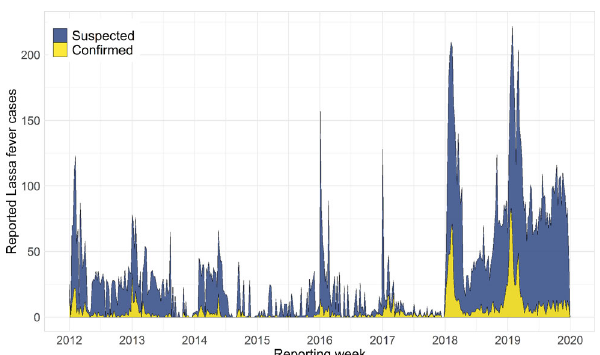
Fig. 1 Temporal trends in country-wide Lassa fever case reporting from 2012 to 2019. Polygon height shows the weekly total cases reported across Nigeria, with colour denoting the proportion of cases that were laboratory- con fi rmed (yellow) or suspected (blue). The full case time series was compiled from two reporting regimes at the Nigeria Centre for Disease Control: Weekly Epidemiological Reports 2012 to 2016, and Lassa Fever Technical Working Group Situation Reports 2017 to 2019 (with case reports followed-up to ensure more accurate counts; datasets shown separately in Supplementary Fig. 1). A full description of case de fi nitions and reporting protocols is provided in